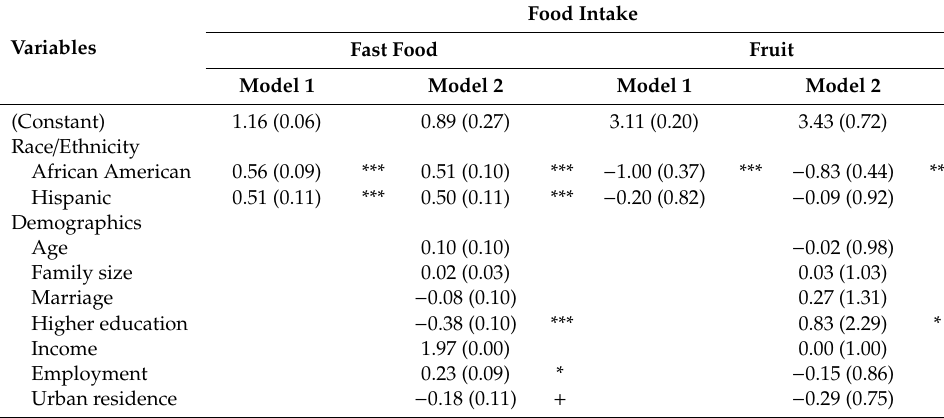
Table 2. Regression results of unstandardized coe ffi cients (standard error) predicting fast food and logistic regression coe ffi cients (odds ratio) predicting fruit